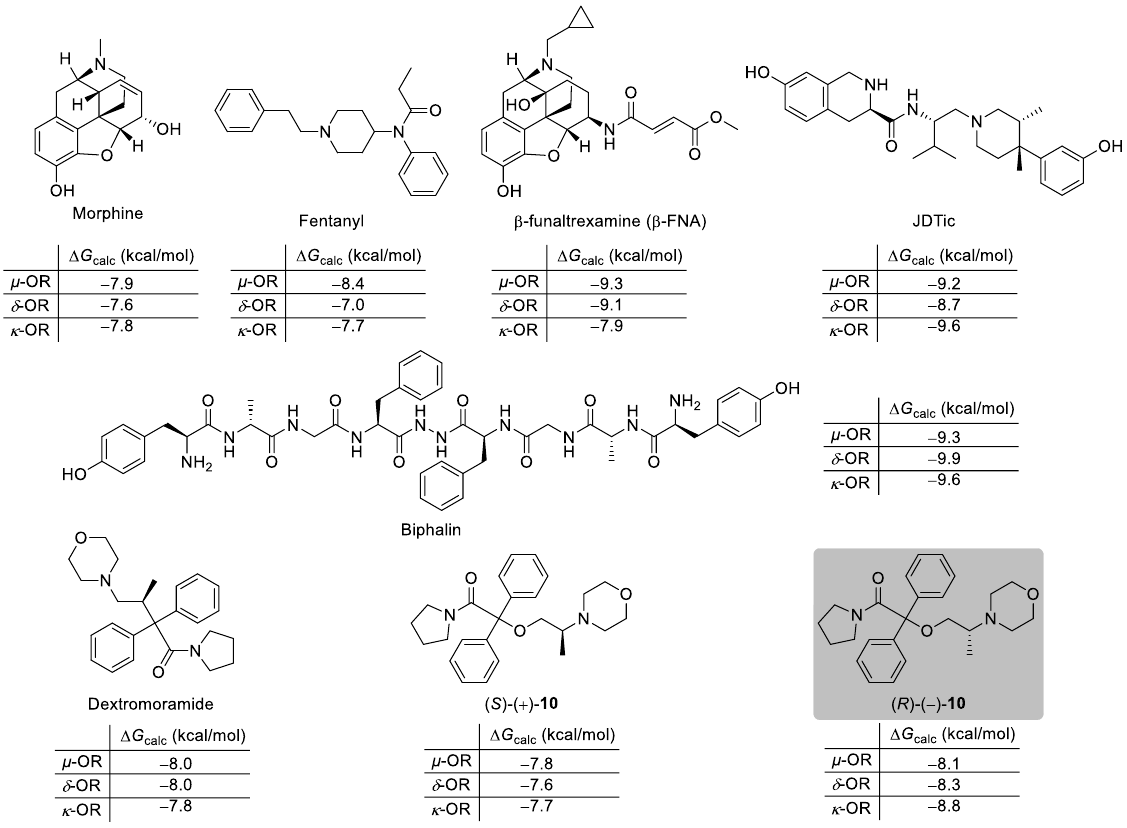
Figure 2. The values of the absolute free binding energies ( Δ G calc (kcal/mol)) obtained using molec- ular docking performed for both enantiomers of ethereal analog of iso -moramide ( S )-(+)- 10 and ( R )-( – )- 10 and benchmark opioids (i.e., morphine, fentanyl, dextromoramide, etc.) complexed with µ -OR, δ -OR, and κ -OR, respectively. The results represent only the calculations for each ligand ’ s most energetically favorable poses, whereas the rest of these data are included in the Supplementary Ma- terials to enhance readability.